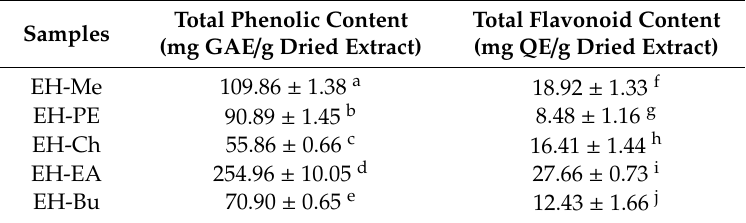
Table 2. Total phenolic and flavonoid contents in E. hirta extracts. Each value is the average of three analyses ± standard error of mean (n = 3). Values with di ff erent superscripts in the columns are significantly di ff erent based on one-way ANOVA followed by Dunnett’s